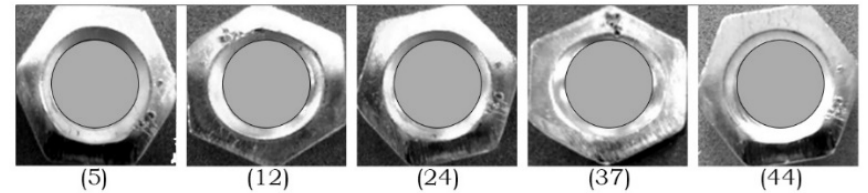
Figure 6. Original system.